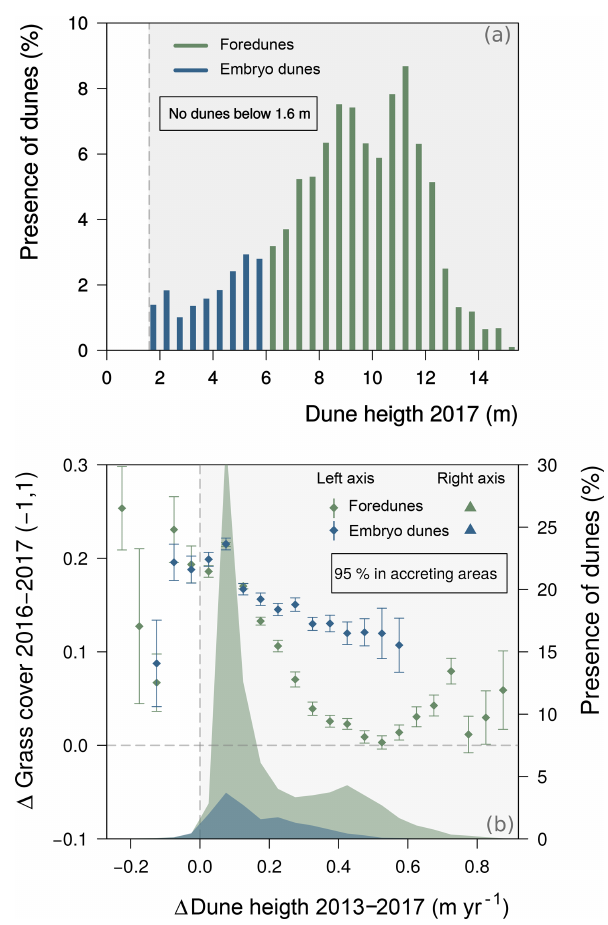
Figure 5. Identifying favorable accommodation space for dune de- velopment (both foredunes and embryo dunes) along the Delfland coast. (a) Comparing the presence of dunes in 2017 to its eleva- tion: no dunes present below 1.6ma.m.s.l. Comparing the changes in dune cover by marram grass from 2016 to 2017 to the average yearly change in dune height between 2013 and 2017: most dunes were present in accreting areas (right axis) and almost all dunes increased in cover by marram grass between 2016 and 2017 (left